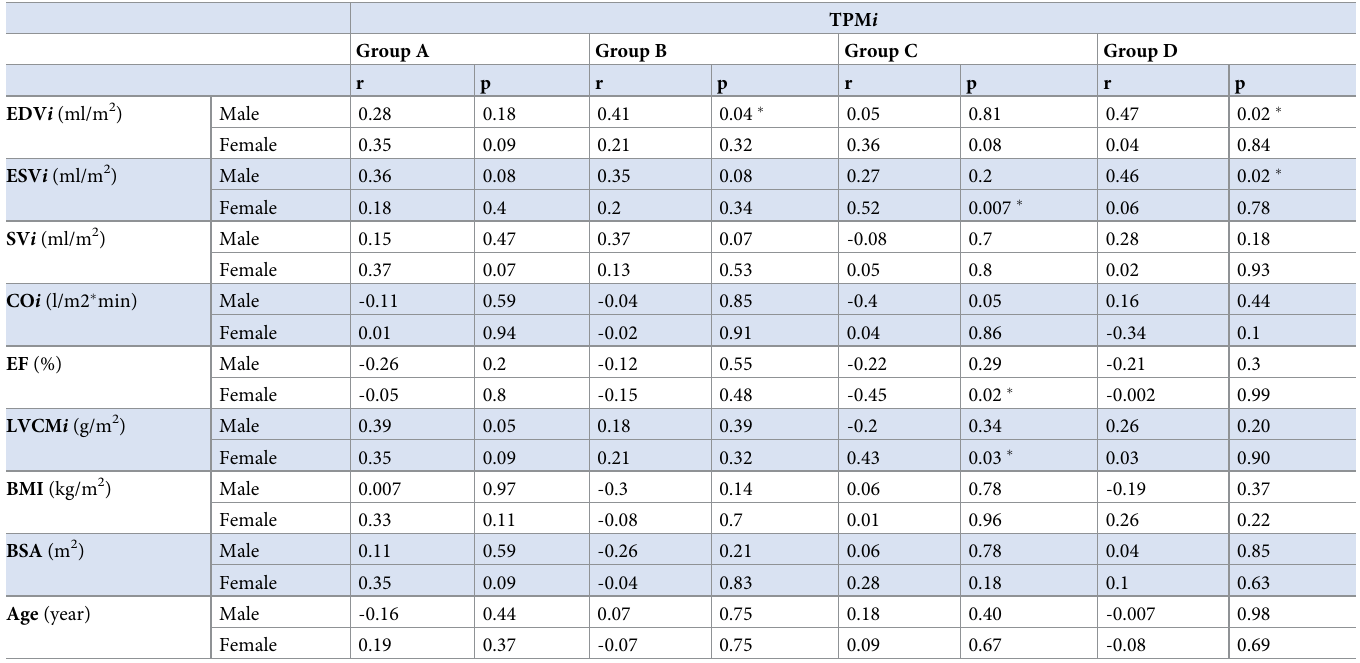
Fig 2. Correlations with the TPMi in the total population. EDVi: End-diastolic volume index, ESVi: End-systolic volume index, SVi: Stroke volume index, COi: Cardiac output index, EF: Ejection fraction, LVCMi: LV end-diastolic compacted myocardial mass index, TPMi: LV end-diastolic papillary and trabeculated muscle mass index, BMI: Body mass index, BSA: Body surface area. � p < 0.05. https://doi.org/10.1371/journal.pone.0258362.g002 Table 3. Correlations with the TPM i divided by